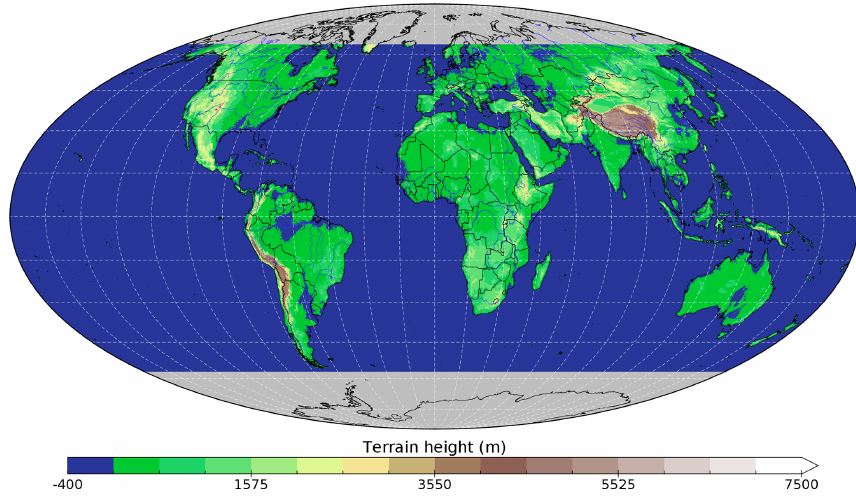
Figure 1. Applied model domain for both the CP and NCP simulations.